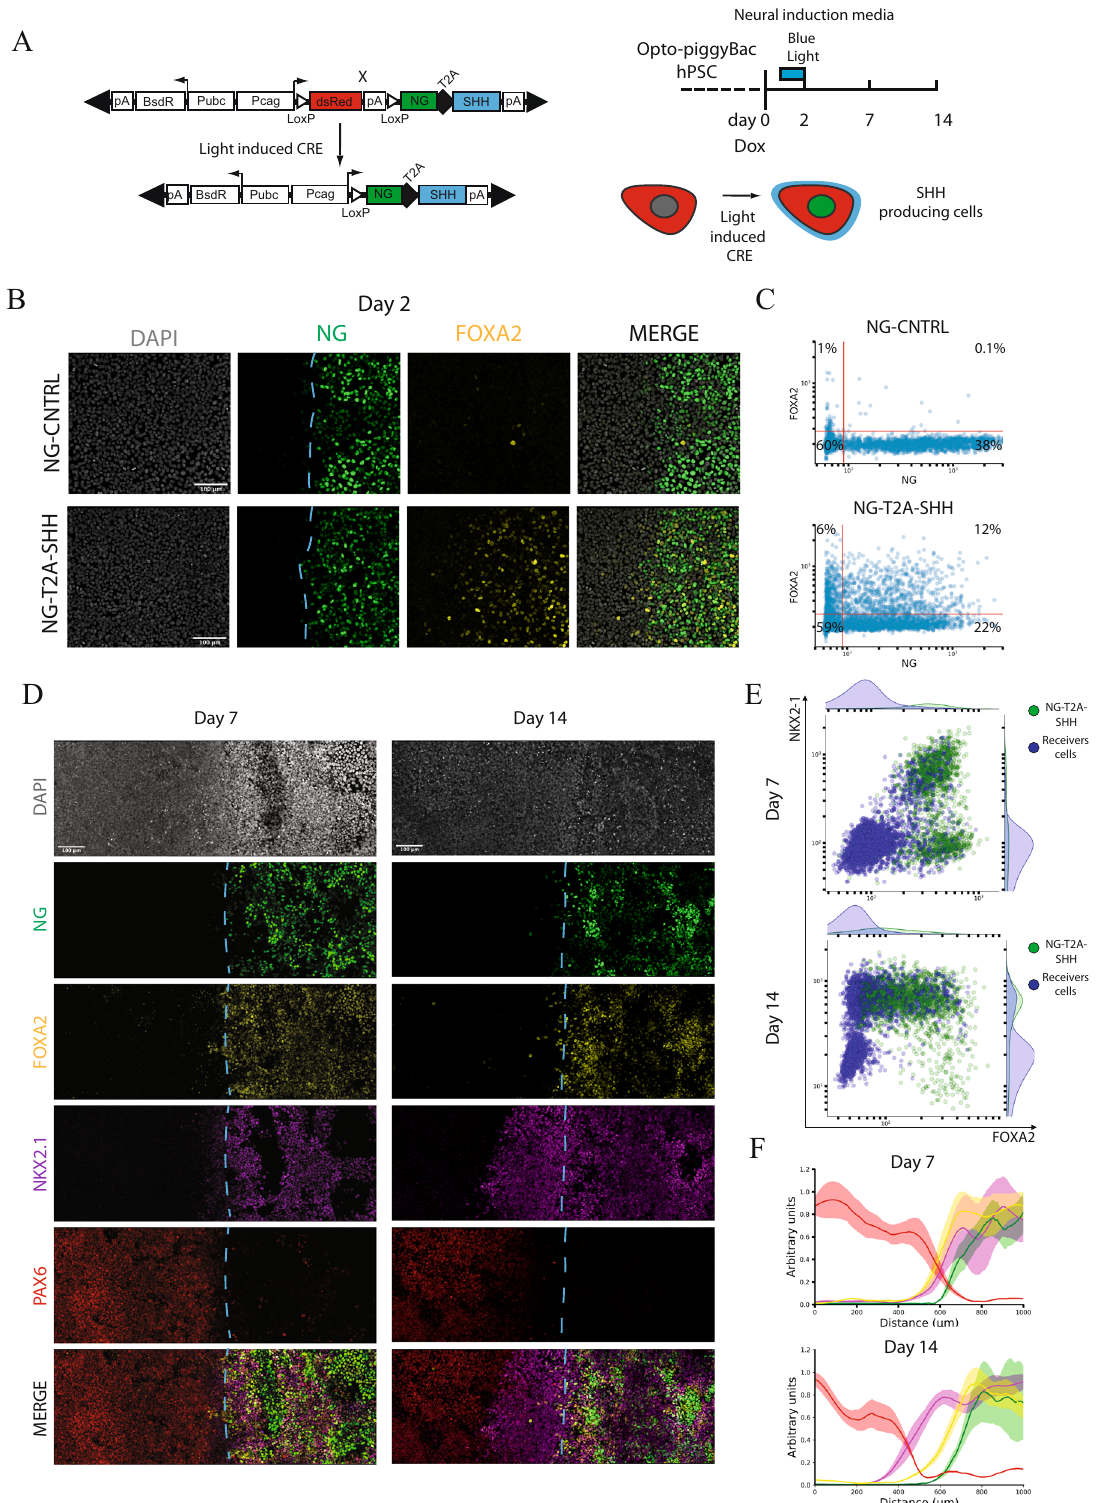
GLI3-GAS1 high /PTCH low cells as unstimulated (Fig. 3C, Supple- mentary Fig. 7A). We also validated the speci fi c induction of SHH signaling in the NG-T2A-SHH line compared to a NG-CNTRL line by testing GLI1 and GLI3 expression at day 14 using qRT- analysis con fi rmed the presence of a FOXA2 + /ARX + , fl oor